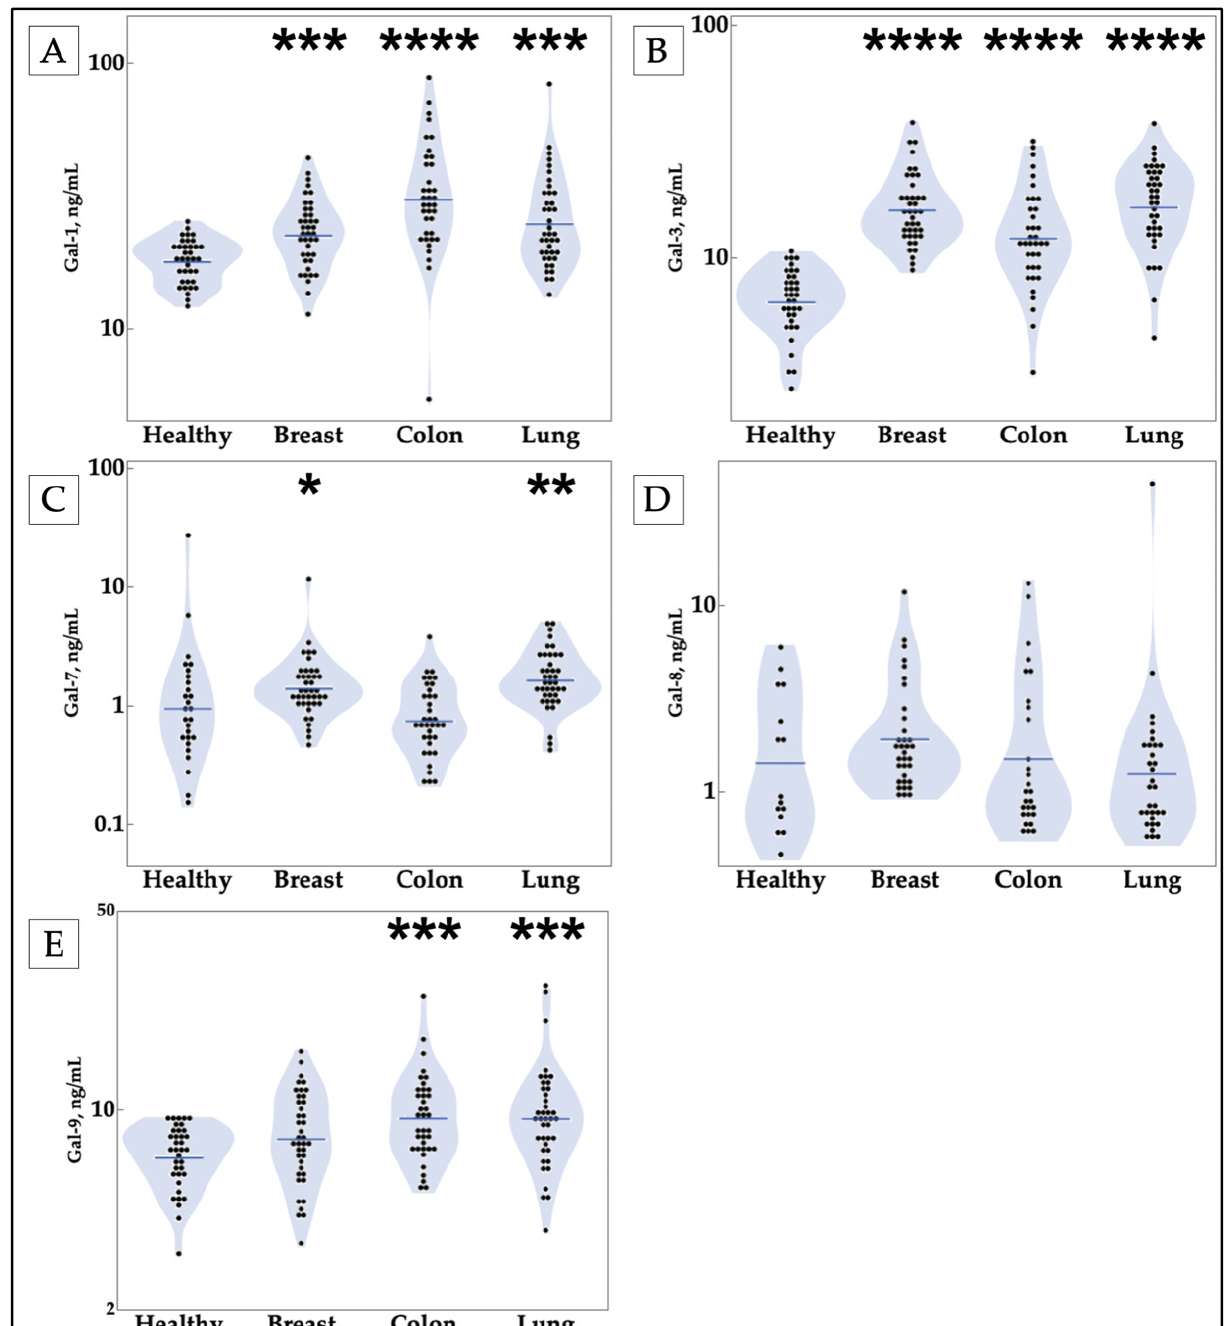
Figure 1. Circulating concentrations of galectins-1, -3, -7, and -9 are increased in breast, colon, and lung cancer patients compared with healthy controls. Cancer galectin levels were determined by ELISA of patient samples. ( A , B ) Galectins-1 and -3 are increased in all three cancer types, ( C ) galectin-7 is increased in breast and lung cancer patient samples, ( D ) galectin-8 shows no statistically significant differences from the healthy control, and ( E ) galectin-9 is found to be statistically significantly increased in colon and lung cancer. Stars indicate the p -values of nonparametric comparisons with control using the Steel method (* p ≤ 0.05, ** p ≤ 0.01, *** p ≤ 0.001, **** p ≤ 0.0001). Gal = galectin.